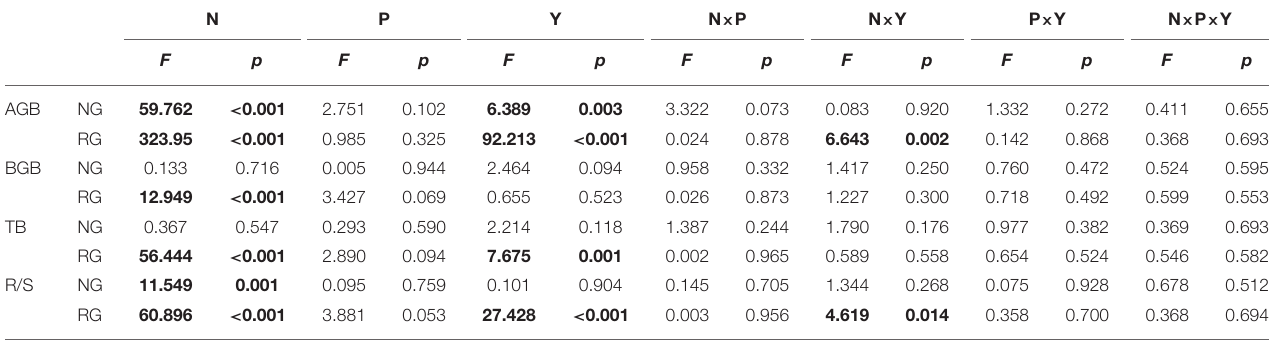
TABLE 1 | Effects of nitrogen addition (N), phosphorus addition (P), and sampling year (Y) and their interaction effects on plant community AGB, BGB, TB, and R/S in the natural (NG) and restored (RG) grasslands.